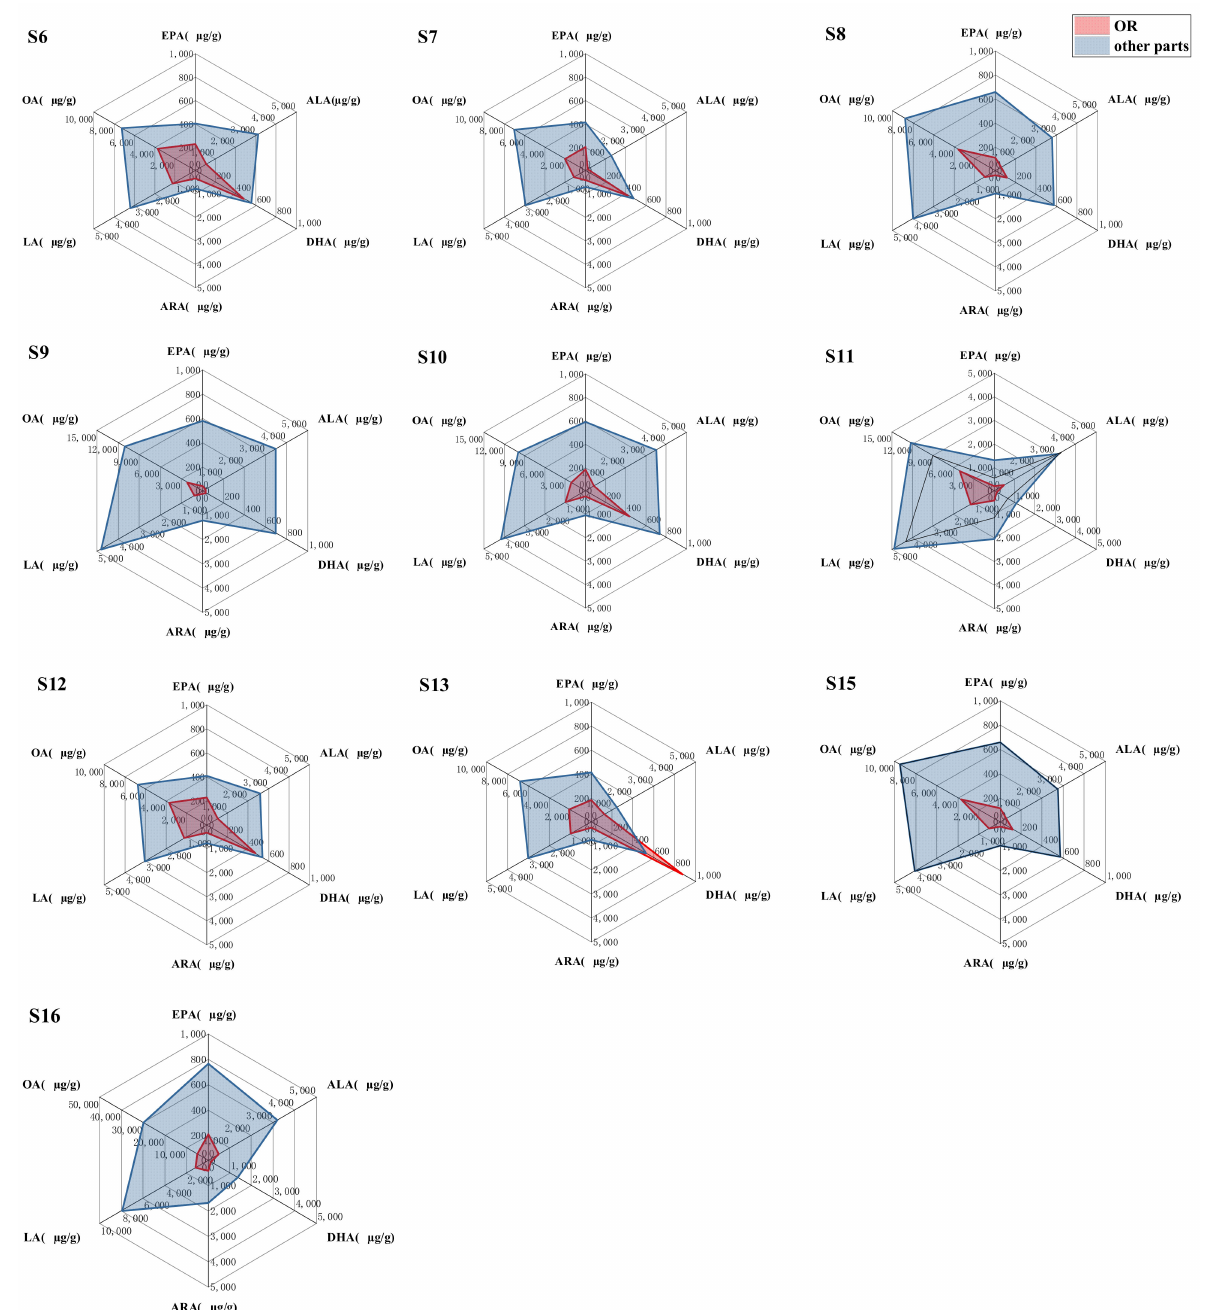
Figure 7. Comparison of the contents of six PUFAs in OR and their average contents in RCO, RCM, RCS, and RCB in the same Rana chensinensis